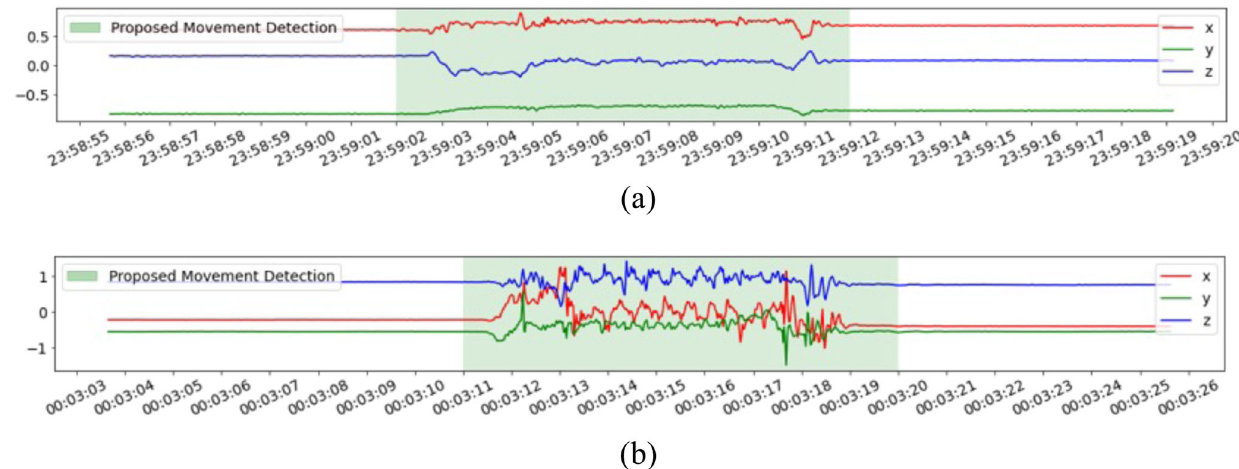
Fig. 1 Finger scratch and hand scratch events. a A fi nger scratch event (low-intensity motion pattern). b A hand scratch event. Table 1. Demographics of study participants. Demographics of 20